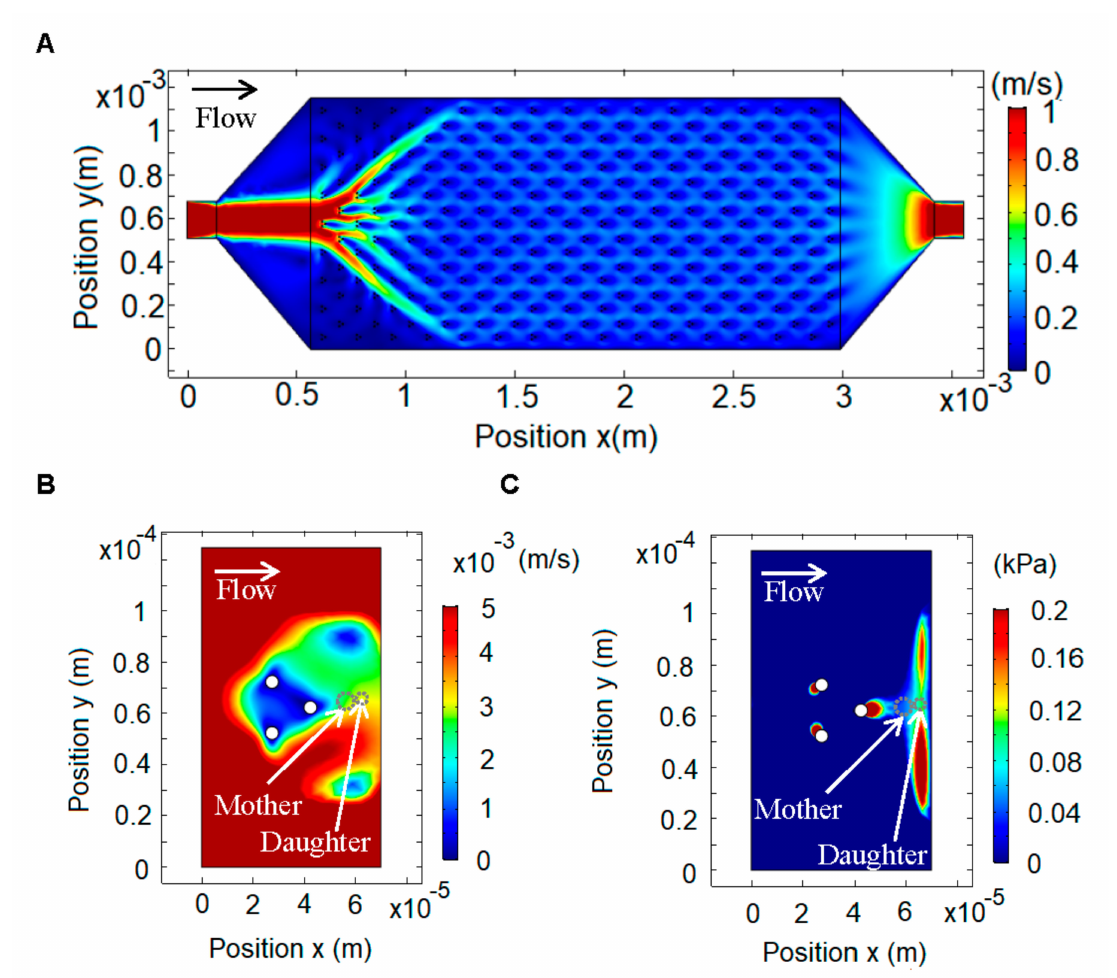
Figure 2. Finite element simulation using COMSOL Multiphysics. ( A ) Velocity profile in a single mother machine channel, with the input on the left and the output on the right, and within it 30 columns, 15 of which have nine rows and 15 of eight rows for a total of 255 traps. ( B ) Flow velocity profile in a single trap. ( C ) Pressure profile in a single